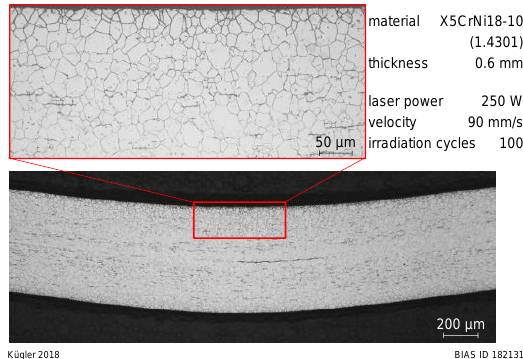
Figure 5. A cross-section of a multiple-irradiated specimen.